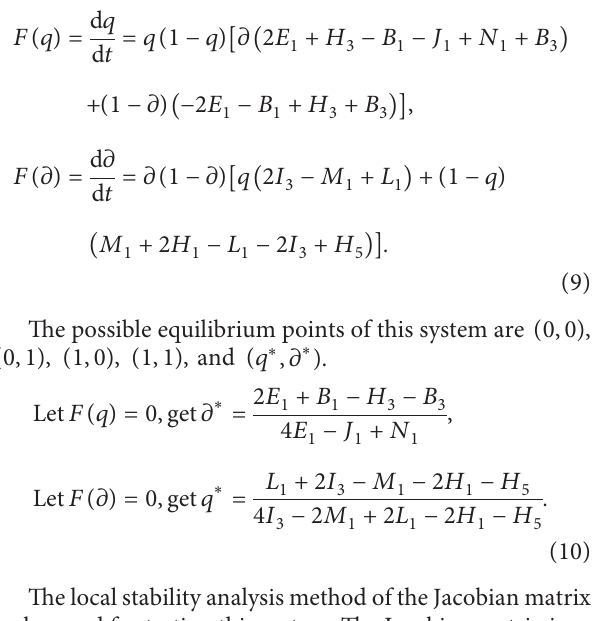
Figure 1: Copying dynamic phase diagram of the central government and the local